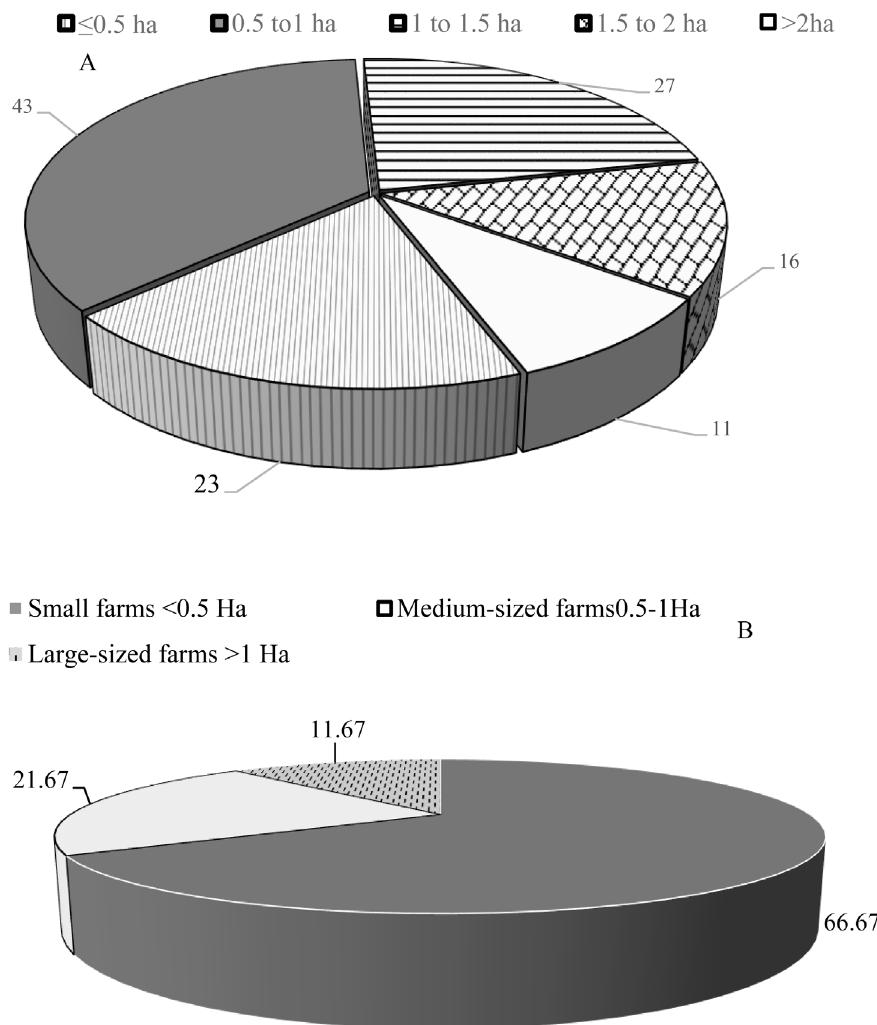
Fig. 2. Farm size of the farmers studied (A (cid:2) Site-FW; B (cid:2)